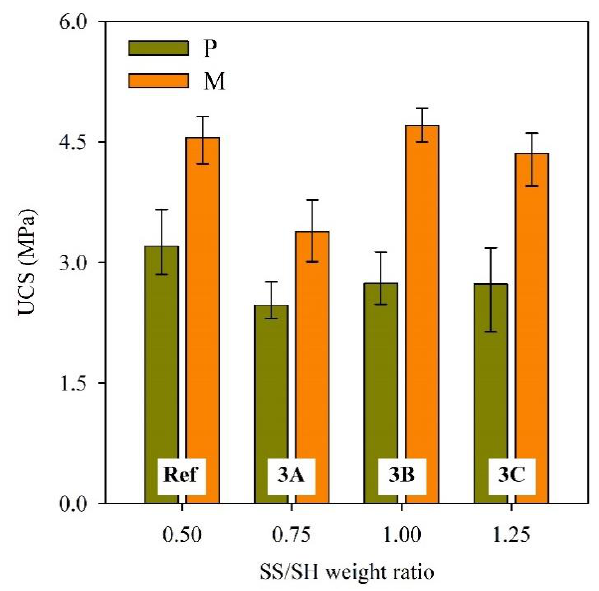
Figure 6. Influence of the silicate / hydroxide weight ratio on compressive strength.